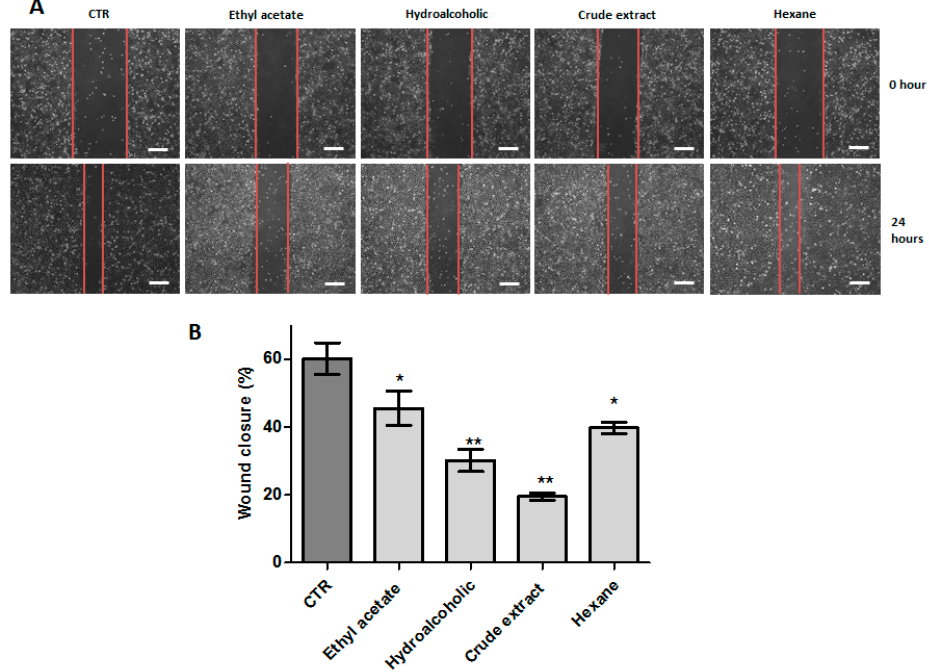
Figure 2. ( A ) Representative images of wound healing assay of HN13 cell line after 24 h, exposed to ethyl acetate fraction (25 µg/mL), hydroalcoholic fraction (10 µg/mL), crude extract (50 µg/mL) and hexane fraction (60 µg/mL). The red lines represent the distance between both edges of the wound; Scale bars, 200 µm; ( B ) bars represent the relative migration expressed as the means ± SD for different compounds. All experiments were repeated for three times. * p < 0.05; ** p < 0.01.